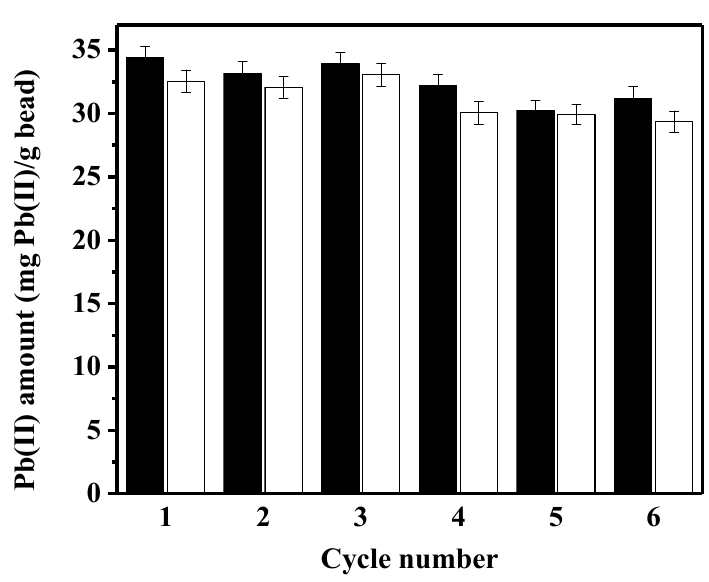
Figure 5. The amounts of lead adsorbed and desorbed during six cycles of successive adsorption- desorption batches (black bar: adsorption, white bar: desorption).